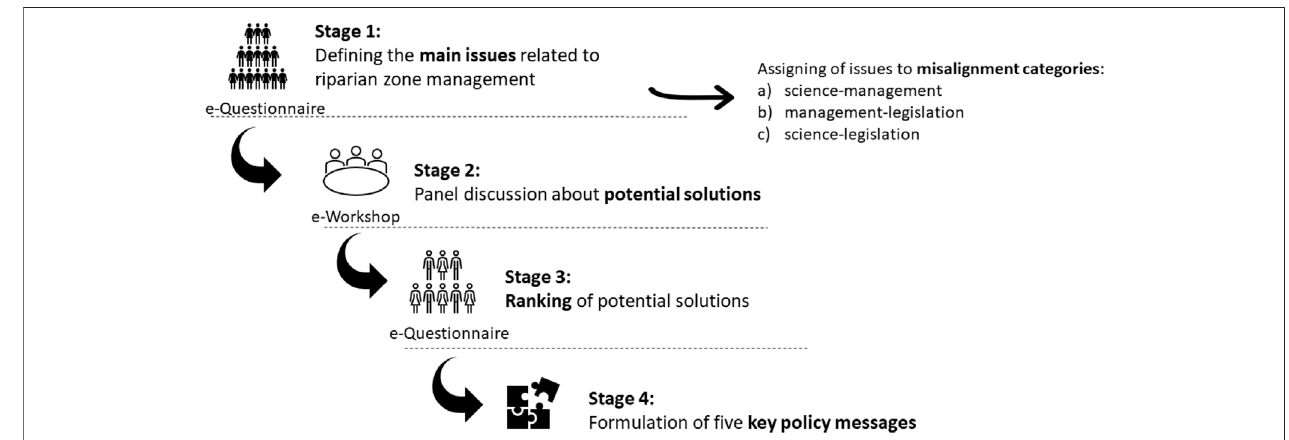
FIGURE 1 | The study design approach from which fi ve key policy messages